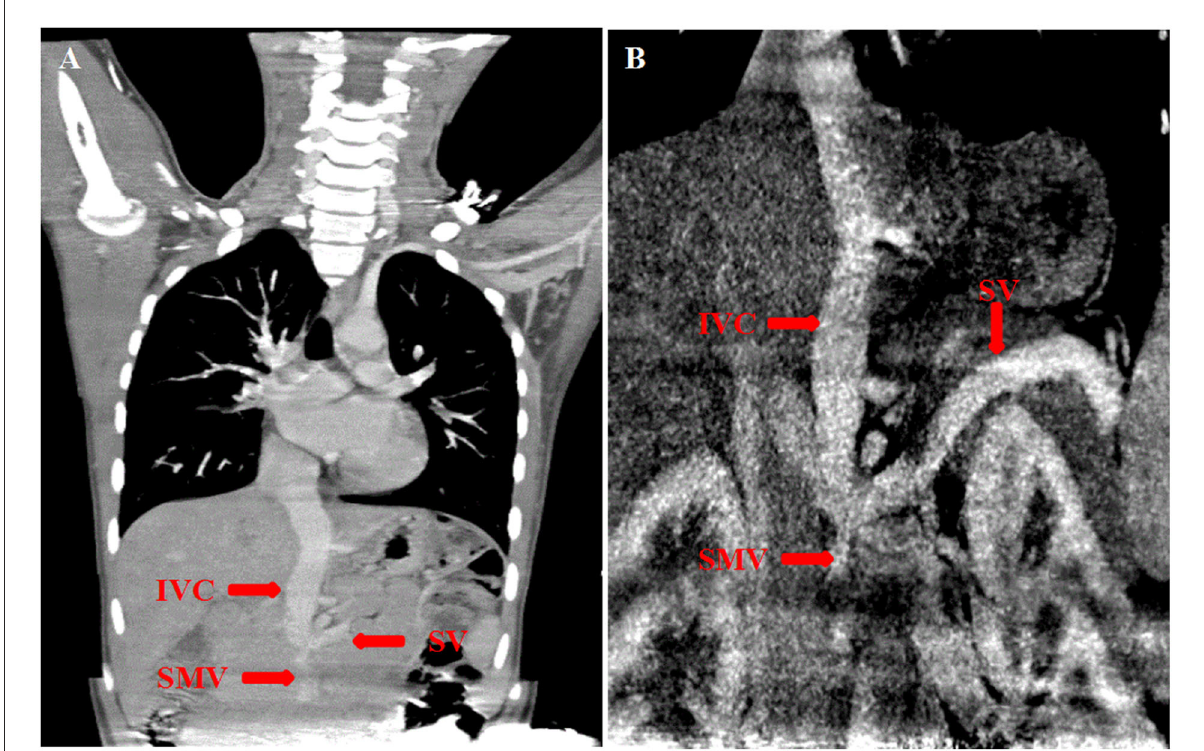
FIGURE2 (A,B) Computer tomography angiography (CTA) showed the splenic vein (SV) joined the superior mesenteric vein (SMV) and then flowed upward into the inferior vena cava (IVC) directly.